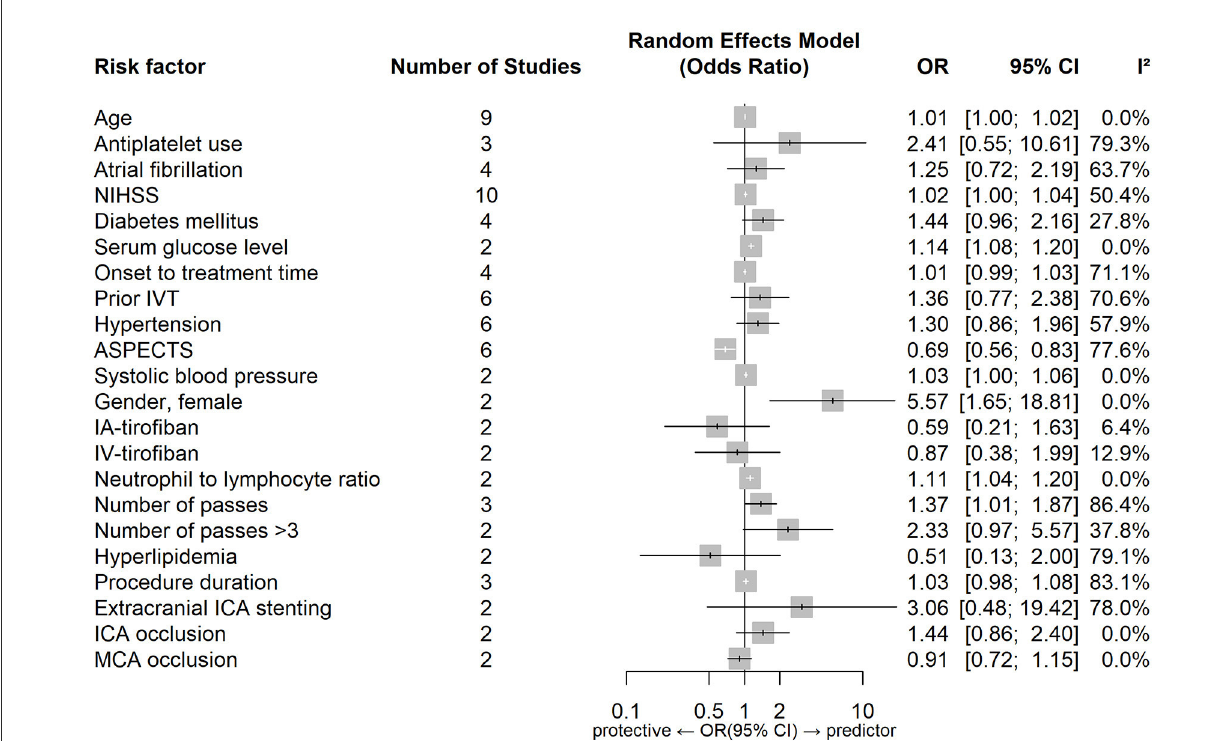
FIGURE5 Forest plot of predictors for sICH after EVT. OR, Odd Ratio; CI, Confidence Interval; NIHSS, National Institute of Health Stroke Scale; IVT, Intravenous Thrombolysis; ASPECTS, Alberta Stroke Program Early CT Score; IA, Intraarterial; IV, Intravenous; ICA, Internal Carotid Artery; MCA, Middle Cerebral Artery.